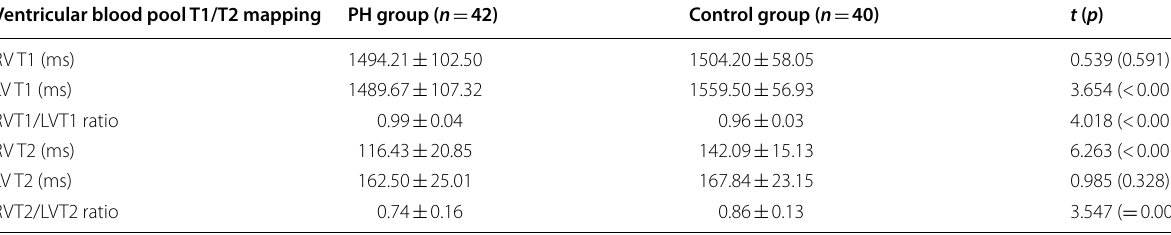
Table 2 Ventricular Blood pool T1 and T2 in patients with PH and the normal control